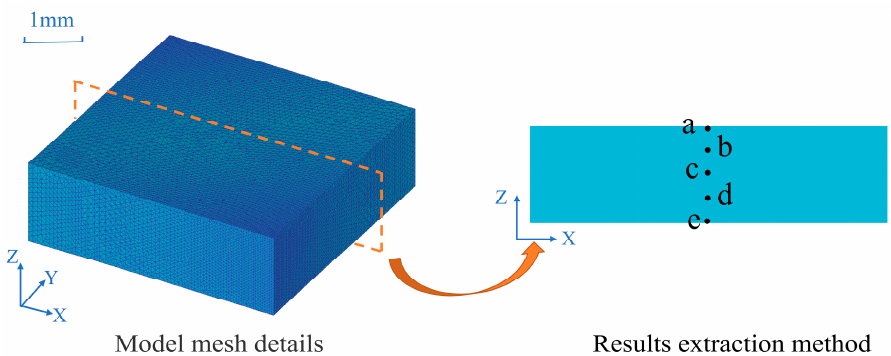
Figure 2. Grid model and analysis point location.